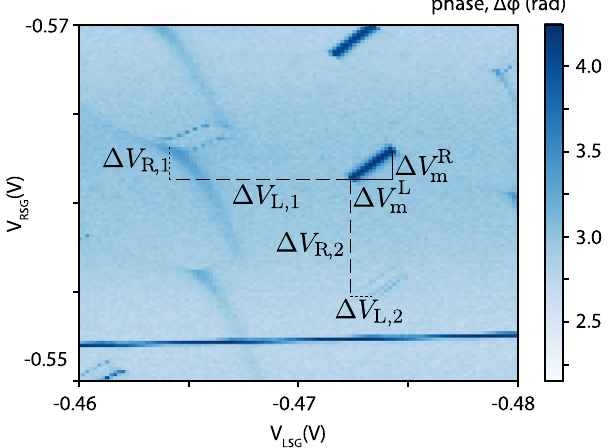
FIG. 7. An example of a DQD charge stability diagram. It shows the phase response of the resonator reflectance while changing the voltage of gates RSG and LSG [see Fig. 1(e)]. The six voltage differences indicated allow one to extract the QDs capacitances and the dipole strength η